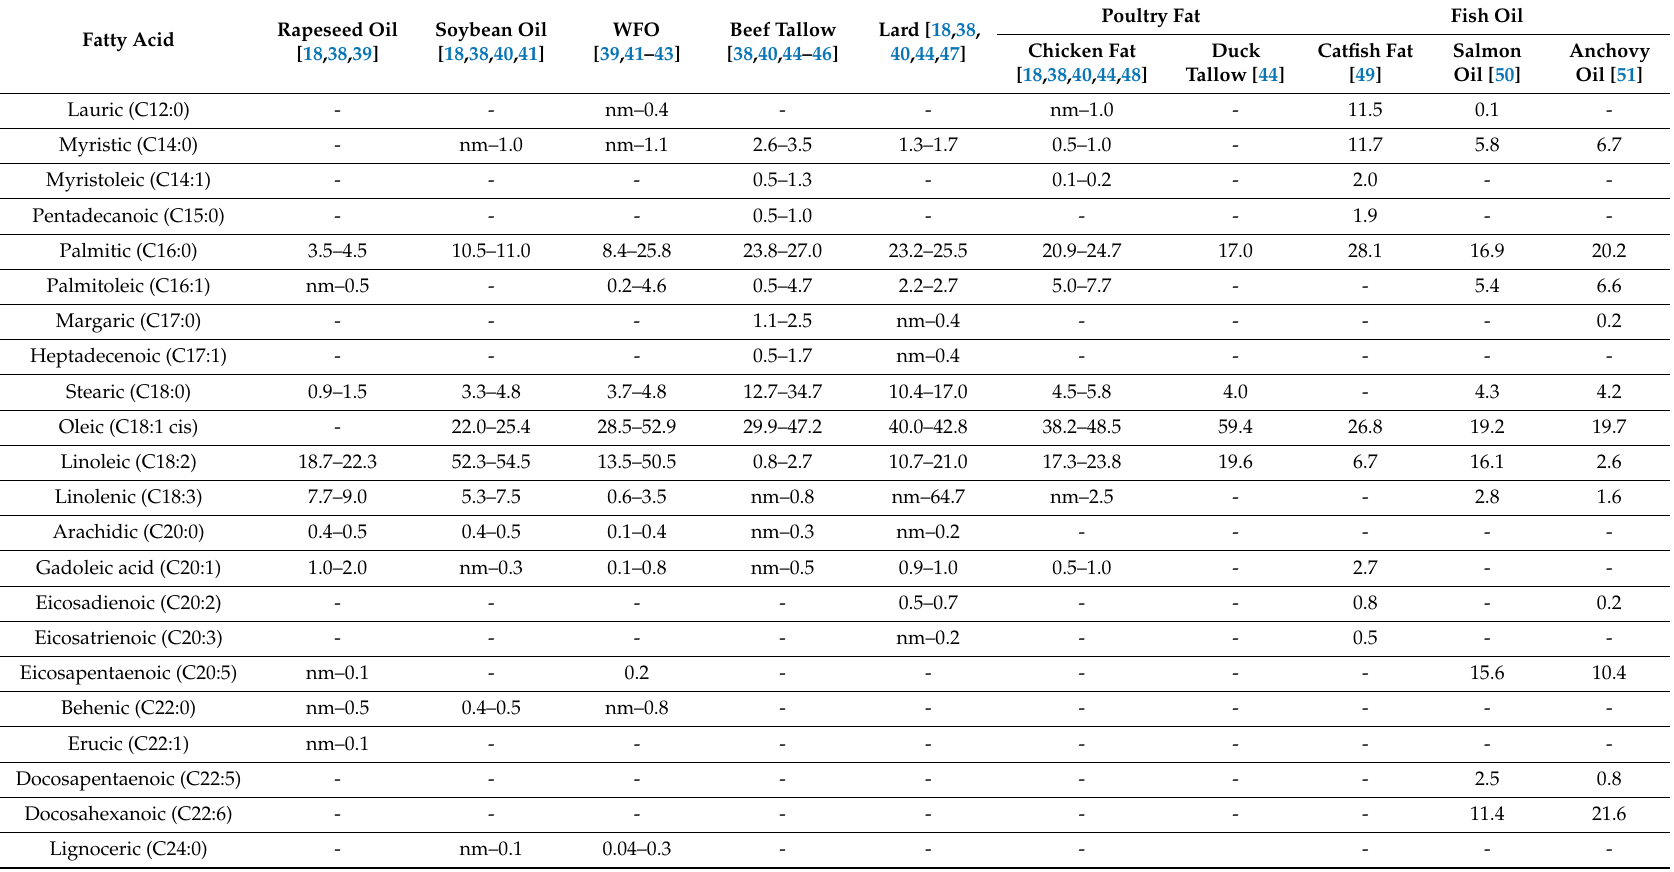
Table 2. Fatty acid profiles of di ff erent feedstocks (minima and maxima weight